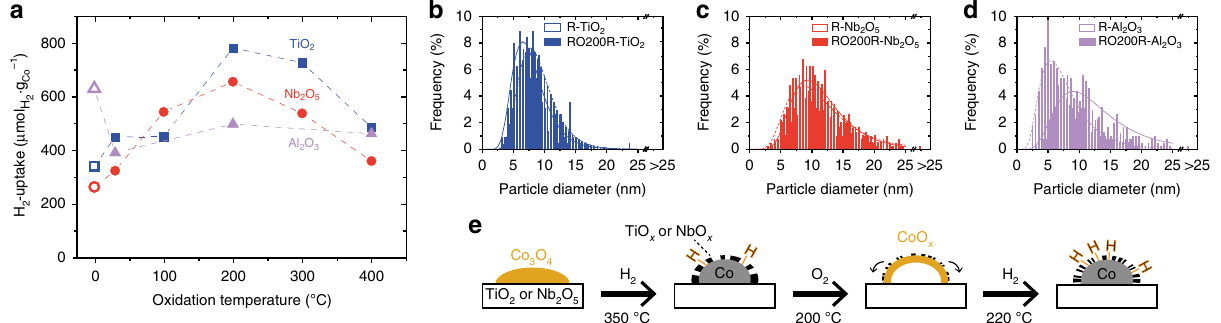
Fig. 3 The effect of ROR treatments on the exposed cobalt surface area and particle size. a Hydrogen uptake for Co/TiO 2 (blue squares), Co/Nb 2 O 5 (red circles), and Co/ α -Al 2 O 3 (violet triangles) after various reduction – oxidation – reduction treatments, as determined by H 2 -chemisorption. The results of the pristine samples after reduction at 350 °C (open symbols) are included at 0 on the x -axis. b – d Particle size distributions of cobalt supported on TiO 2 , Nb 2 O 5 , and α -Al 2 O 3 , respectively, after reduction at 350 °C (open bars) and after reduction at 350 °C followed by oxidation at 200 °C and reduction at 220 °C (solid fi lled bars), as determined by STEM-EDX. e Schematic illustration of the effect of the ROR treatment on cobalt supported on reducible and RO200R-samples and for RO400R-Nb 2 O 5 (Supplementary Figure 4 and Supplementary Table 2). The DOR for the R- samples was 97 – 98% and decreased slightly to 84 – 95% after ROR.